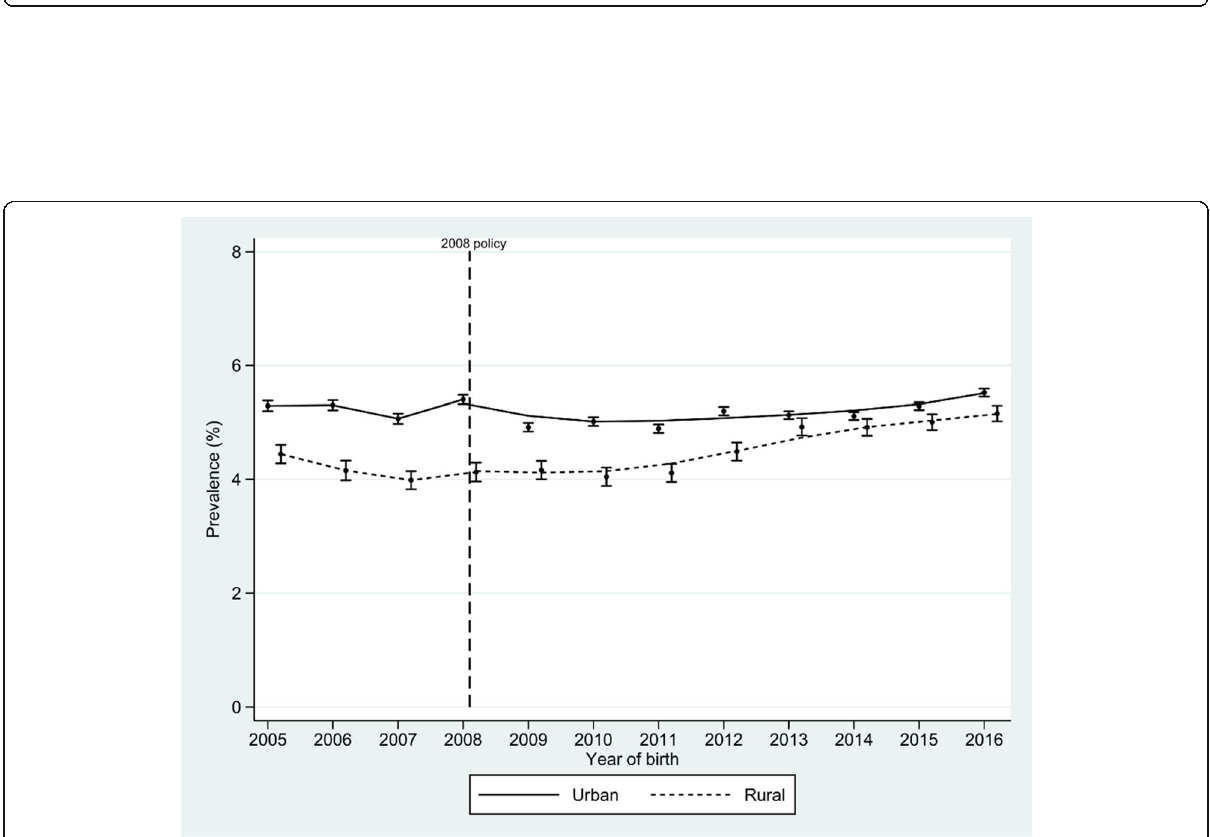
Fig. 1 Mean birth weight trends by year and area of residence, Peru, 2005 – 2016. Dots represent mean birthweight (g) and vertical lines represent 95% confidence intervals for the mean